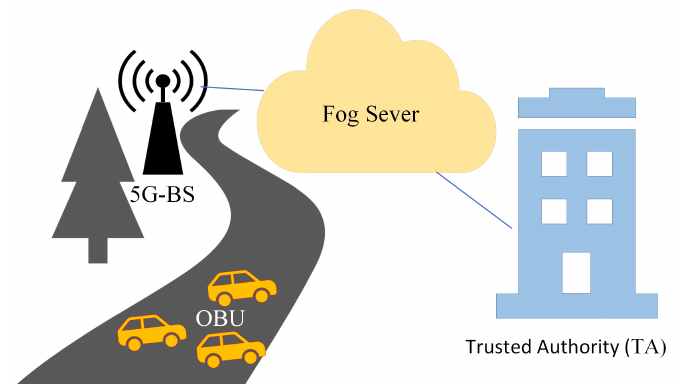
Figure 1. Architecture of Our